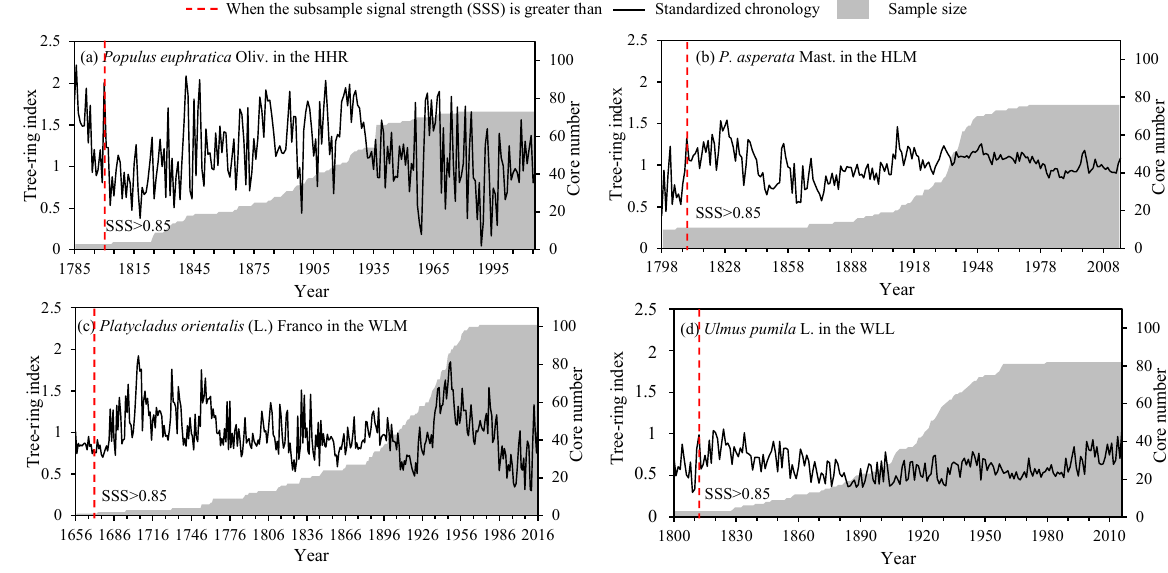
Figure 3. Standard chronological table, sampling size, and SSS for different tree species. Table 2. Standard chronological table and statistical indices for different regions. Table 1. Summary of sampling in each sampling